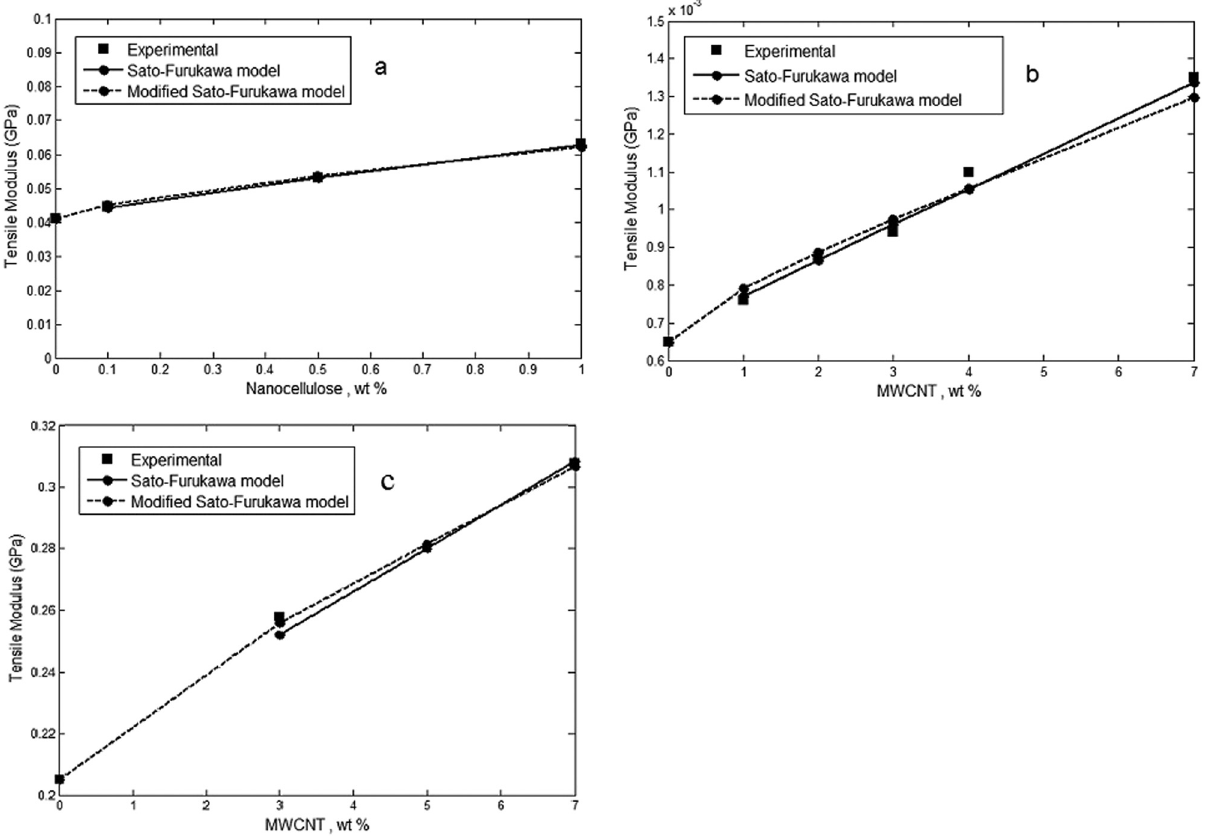
Figure 4: The calculations of Sato – Furukawa and modi fi ed Sato – Furukawa models for ( a ) PU/nanocellulose ( No. 4 ) , ( b ) PDMS/MWCNT ( No. 7 ) and ( c ) PU/MWCNT ( No. 8 ) samples.